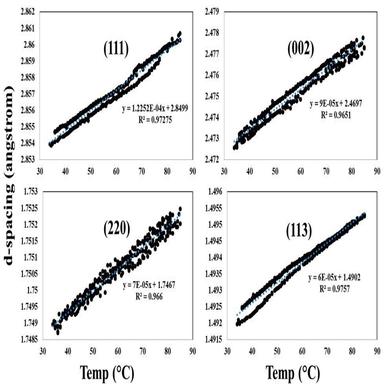
Fitted peak position vs. temperature for the Pb-Ba (111), (002), (220), and (113) reflections after one thermal cycle.